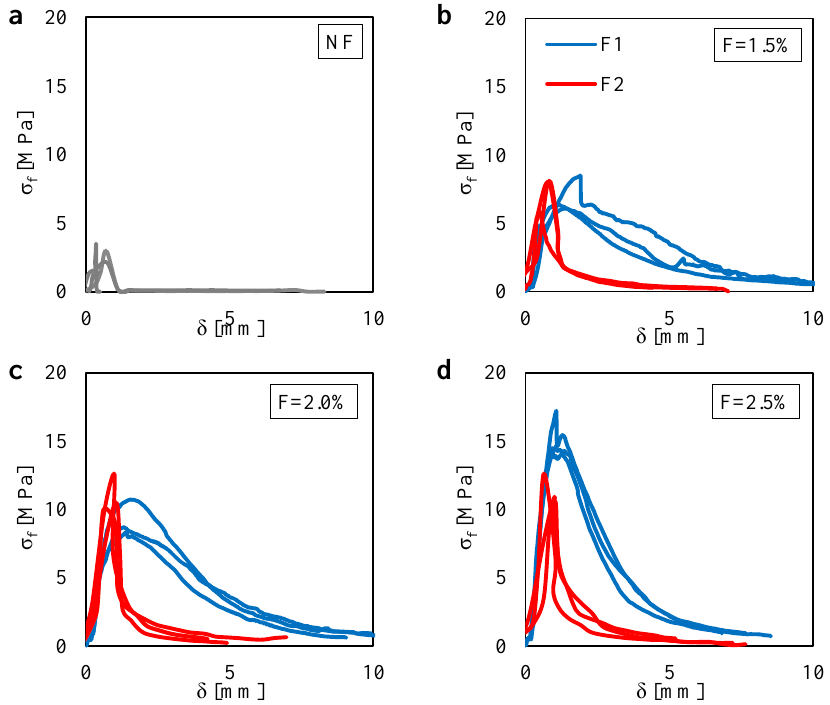
Figure 6. Flexural stress σ f related to the vertical displacement δ measured in the 3PBT for: ( a ) the unreinforced case (NF). Reinforced cases by assuming two fiber types (F1 and F2) with fiber contents equal to ( b ) 1.5%; ( c ) 2.0% and ( d ) 2.5%.